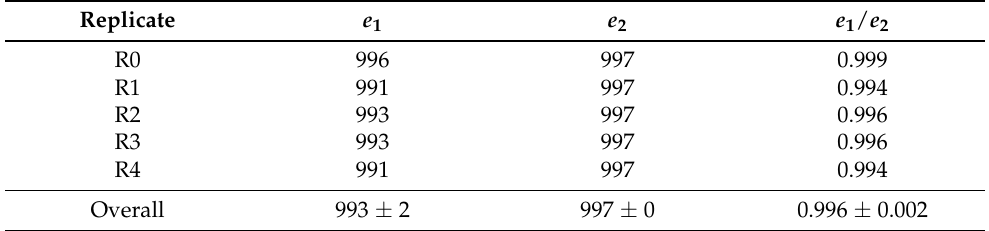
Table A1. 1000M1 Resolution. Here, e 1 is the number of internal edges in the “PIMT”, or the Potentially Inferrable Model Tree, where the zero-event edges are collapsed, and e 2 is the number of internal edges in the binary model tree. The mean ± standard deviation is shown in the Overall row.